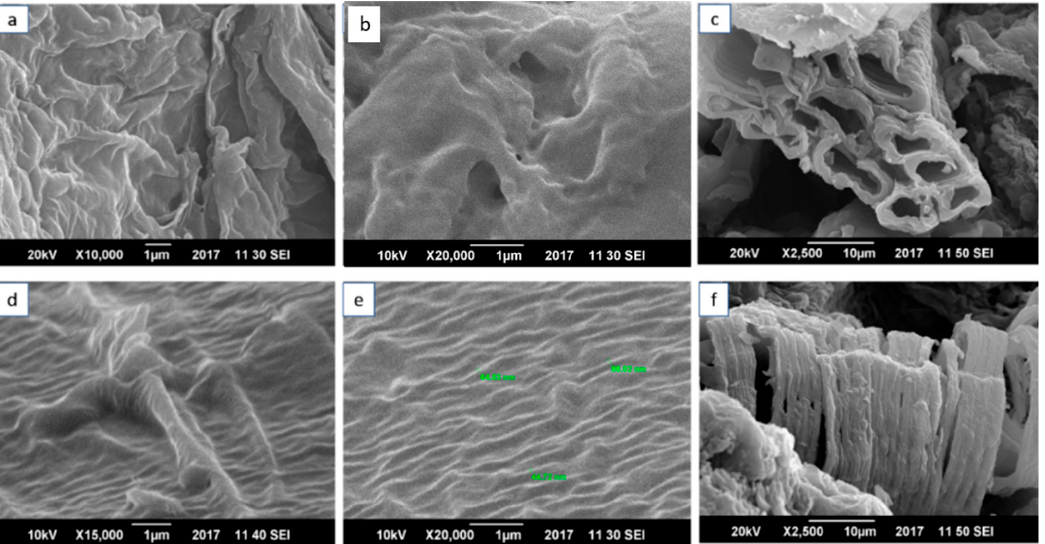
Figure 4. Scanning-electron-microscopy images of ( a – c ) NCP at 1 µ m resolution for ( a , b ) at voltages of 20 kv and at 10 µ m for ( c ) at 10 kv; ( d – f ) CCP at 1 µ m resolution for ( d , e ) at voltages of 20 kv and at 10 µ m for ( f ) at 10